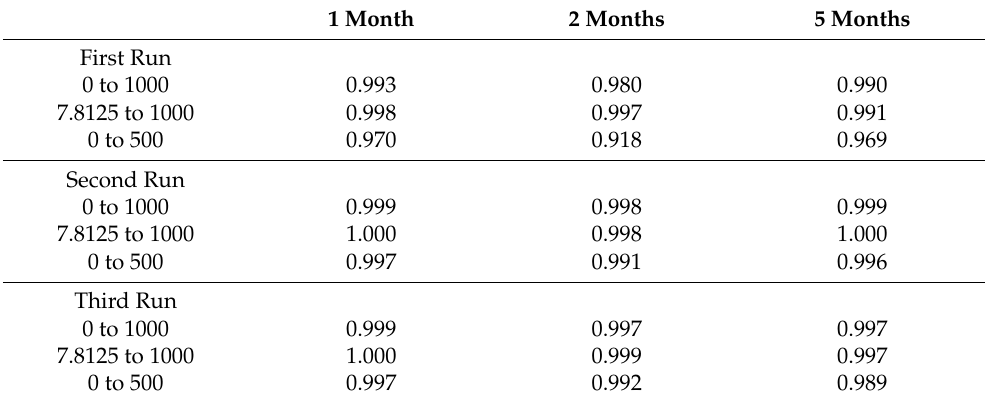
Table 3. Correlation coefficients between ALT [U/L] and maximum reaction velocity [milliunits/min] are stable for the high NADH ALT reagent for at least 5